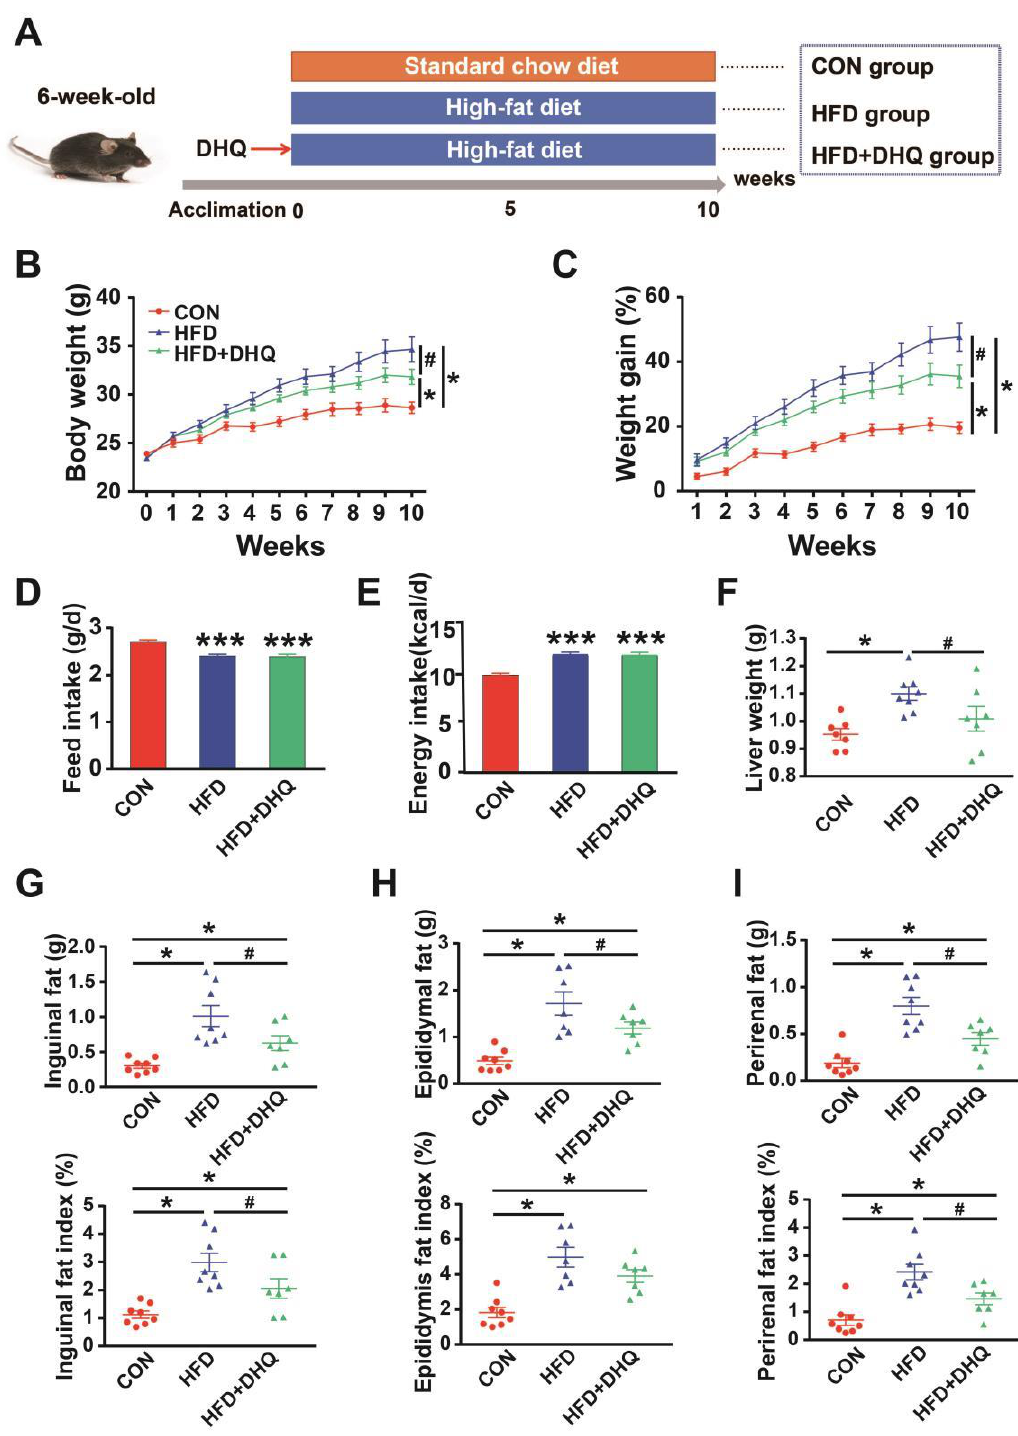
Figure 1. Effects of DHQ on growth performance and lipid deposition in mice. ( A ) Animal breeding scheme (three groups); ( B ) body weight; ( C ) weight gain; ( D ) feed intake; ( E ) energy intake; ( F ) liver weight; ( G ) inguinal fat weight and index; ( H ) epididymal fat weight and index; ( I ) perirenal fat weight and index. Data were expressed as the mean ± SEM. * p < 0.05, *** p < 0.001 vs. CON group, # p < 0.05 vs. HFD group.